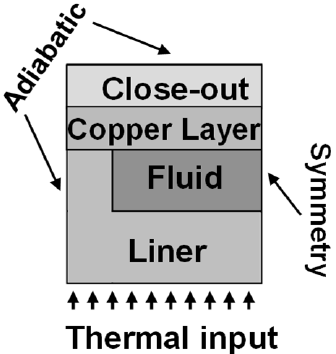
Figure 6. Schematics of the cooling jacket: cross-section view, including information on materials and adopted boundary conditions.